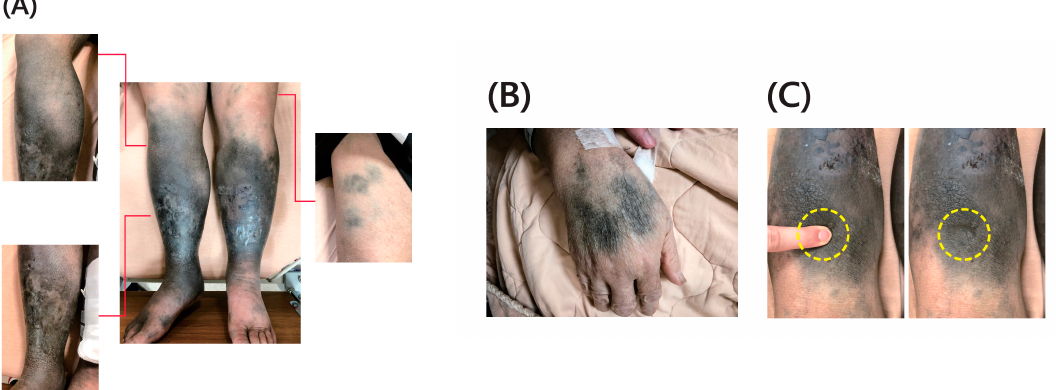
Figure 1. ( A ) Severe, dark black discoloration patches with local scarring of hyperpigmentation noted on bilateral lower legs. ( B ) The non-palpable and non-pruritic bluish discoloration patches on arms. ( C ) There was no local swelling, heat, tenderness, or erythematous changed at bilateral lower legs. The compression test on bilateral lower legs showed no blanching with pressure.